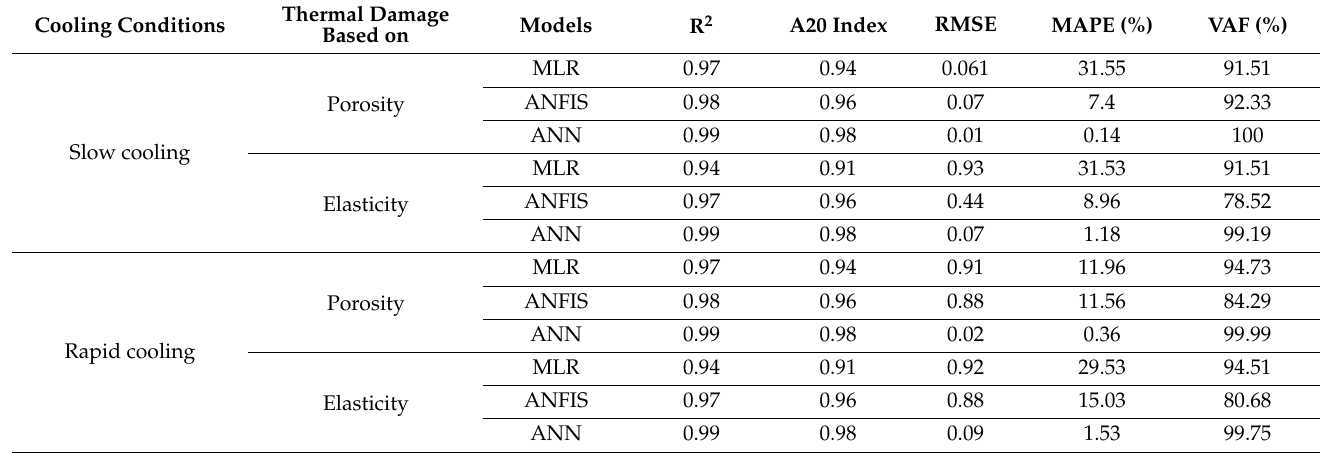
Table 4. Performance indices of the developed